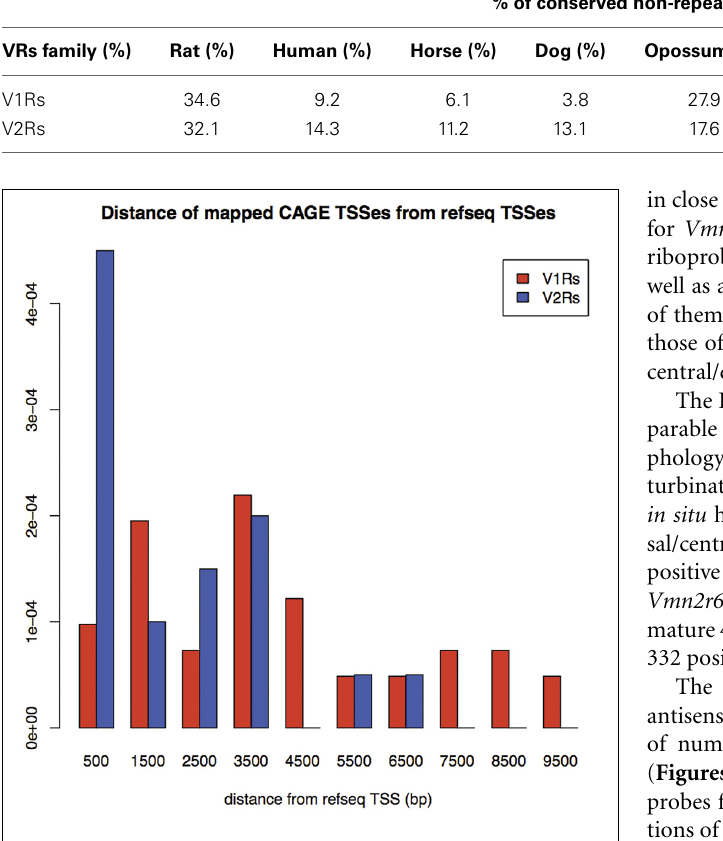
FIGURE 1 | Density of distances between mapped TCs identified by nanoCAGE and associated with VRs, and annotated TSS for RefSeq V1Rs and V2Rs. On the X-axis: Distance from RefSeq TSSs in basepairs; on the Y-axis: Frequency of mappings. The mean distance for V1Rs is higher than for V2Rs, in agreement with the observation that most of V1Rs genes are only annotated as single-exon ORFs whereas V2Rs genes have annotated exon-intron